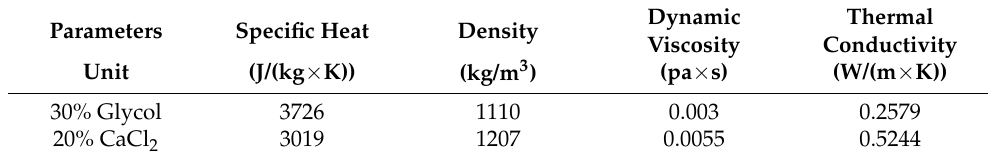
Table 2. Properties of glycol and brine